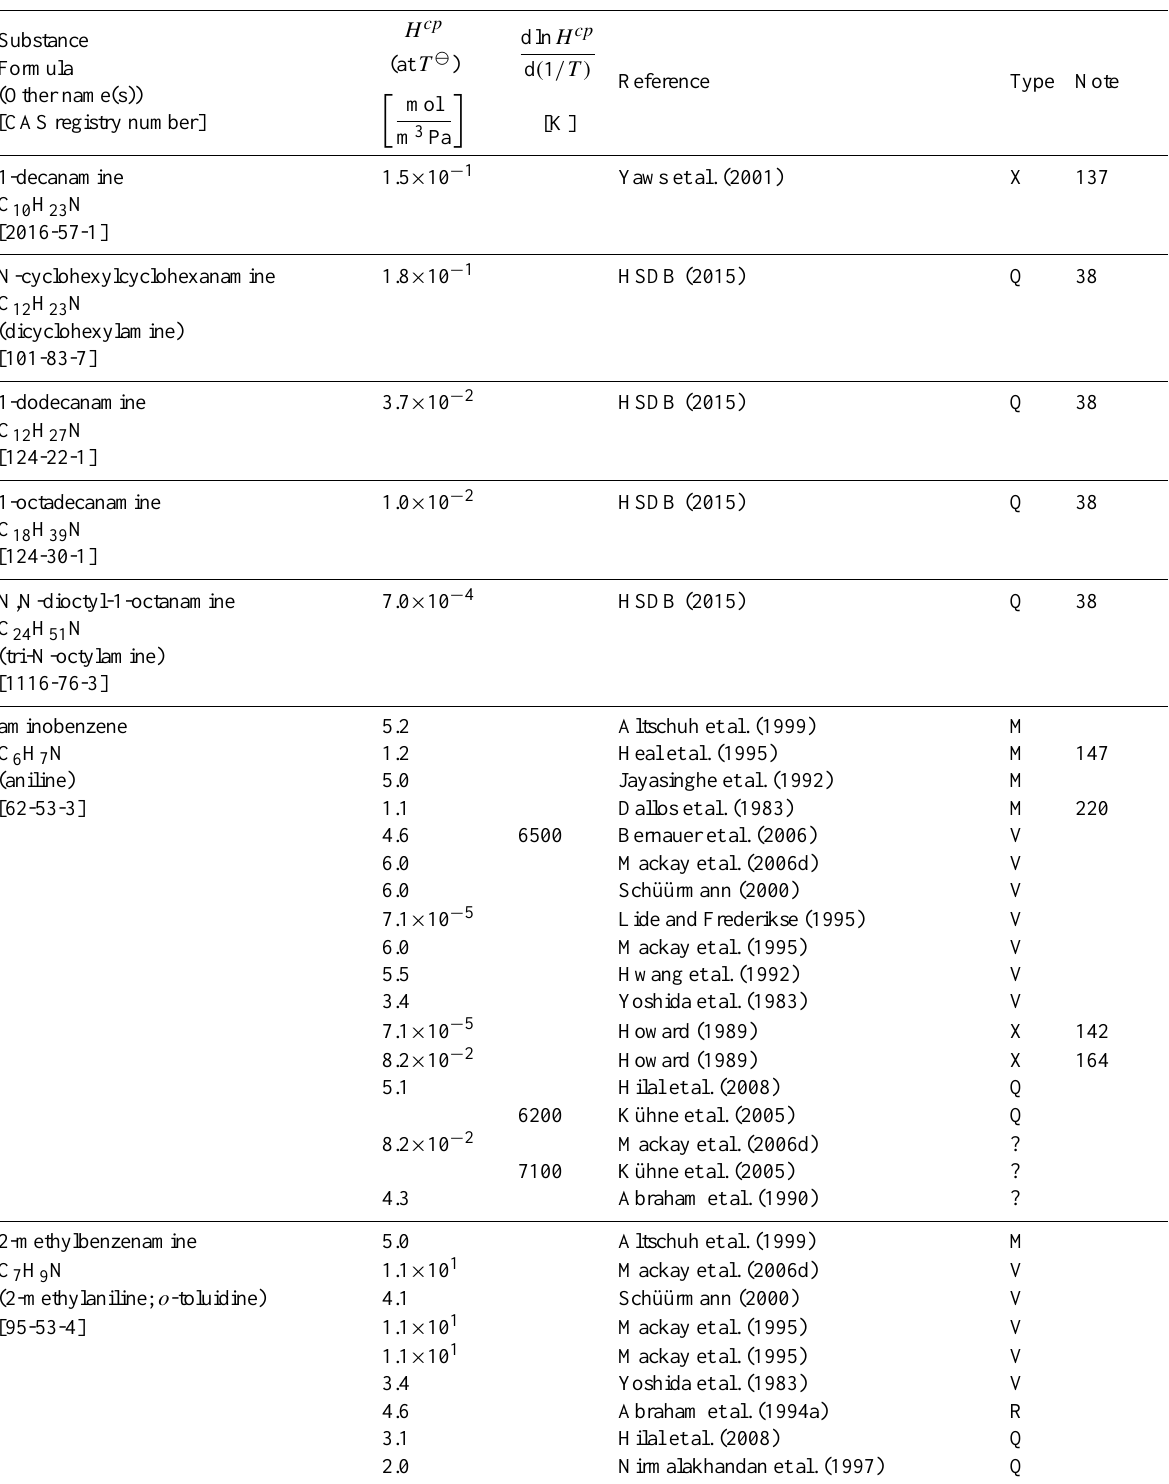
Table 6: Henry’s law constants for water as solvent